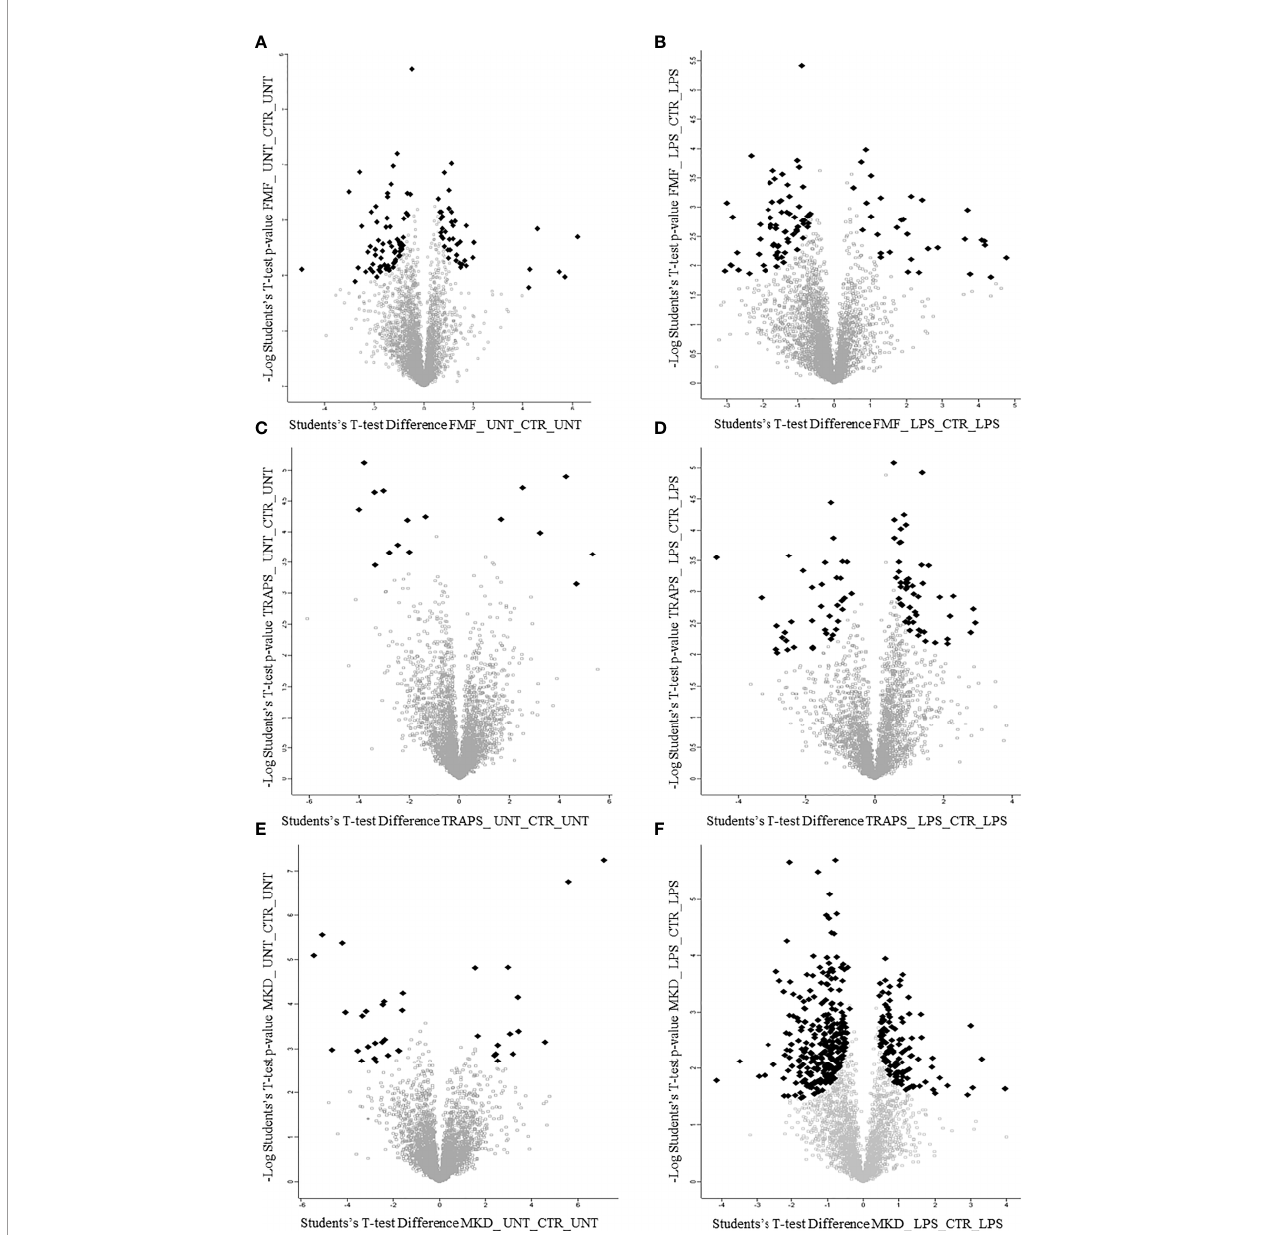
FIGURE 2 | Volcano plots show proteins of untreated and LPS-treated monocytes of patients with FMF (A, B) , TRAPS (C, D) and MKD (E, F) . Black dots represent proteins with large magnitude fold-changes (x-axis) and high statistical signi fi cance (y-axis; p = −